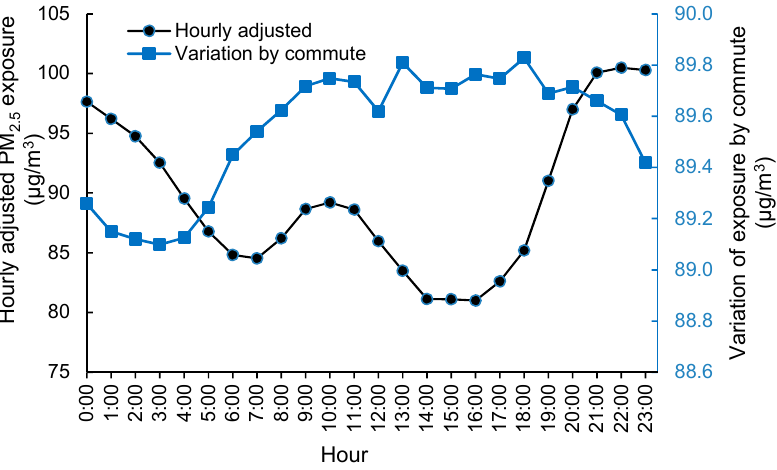
Figure 4. Average hourly variation of PM 2.5 exposure from 2013 to 2015. The blue line represented the hourly variation solely caused by the commute of the population, and the black line represented the total variation caused by both the commute of the population and the hourly change of PM 2.5 concentrations.